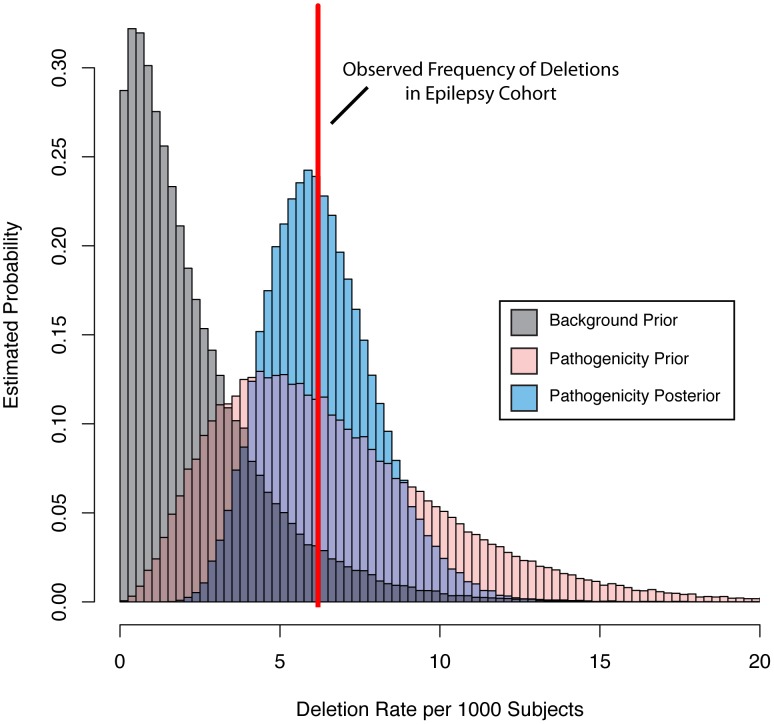
Bayesian integration of pathogenicity scores and mutation frequency for the KCTD13 gene.We parameterized a prior gamma distribution that models the baseline deletion frequency by setting the mean equal to the observed deletion rate in a background population referred for non-neurologic indications (grey distribution). We then varied the mean of a second gamma distribution based on the pathogenicity score (pink distribution). Next, we computed the probability of the observed rate (red line) of deletions among our subjects with epilepsy under the background and pathogenicity-informed models to arrive at the Bayes factor. Finally, we determined the posterior rate distribution (blue distribution), taking into account gene knowledge from the pathogenicity score, background deletion frequency from the non-neurologic cohort, as well as the observed rate among subjects with epilepsy.